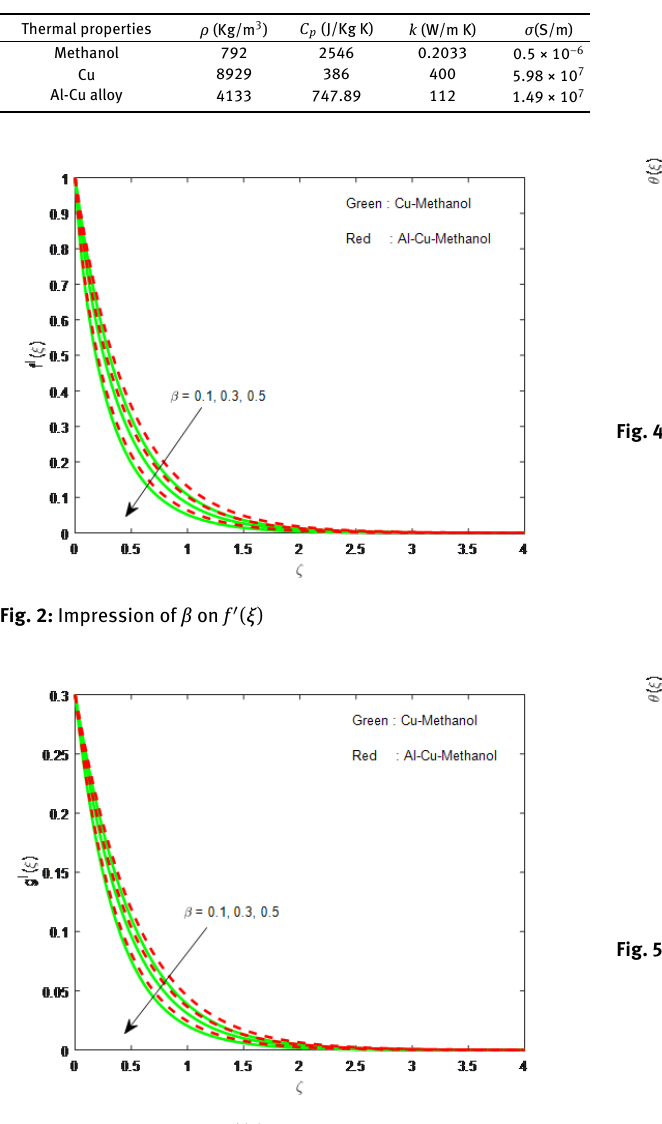
Fig. 3: Impression of β on g (cid:48) ( ξ )